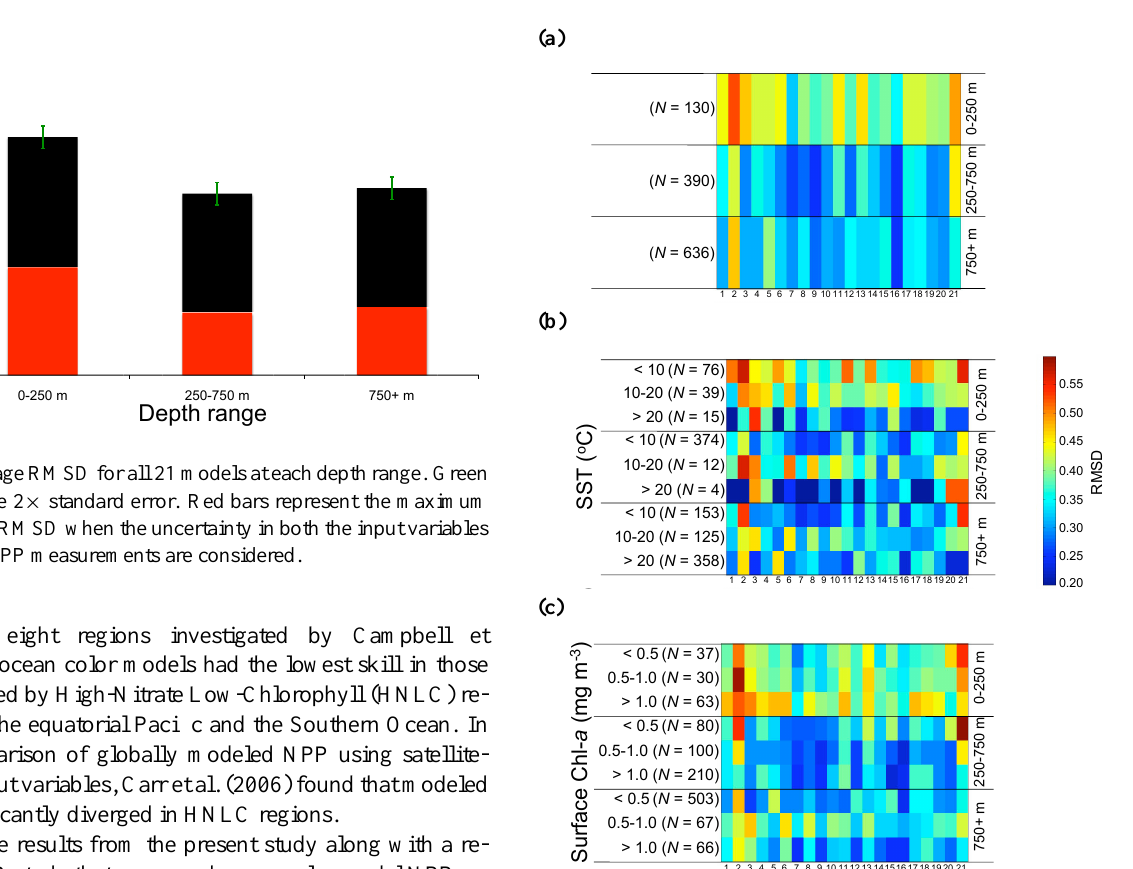
tionship between SST and ocean color model-data misfit is a function of SST range. At SST less than 10 ◦ C, model-data misfit increases with increasing SST while at SST greater than 10 ◦ C, misfit decreases with increasing SST (Fig.